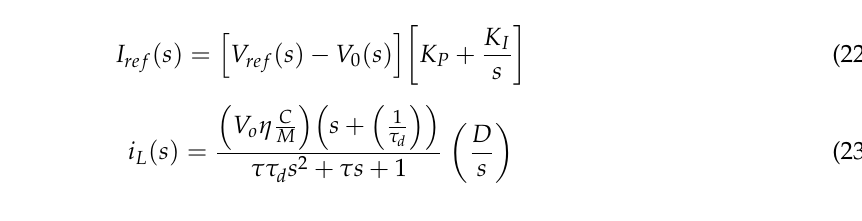
Table 2. With 0% overshoot Cohein-Hrones-Reswick (CHR) formula for Proportional-Integral (PI) tuning